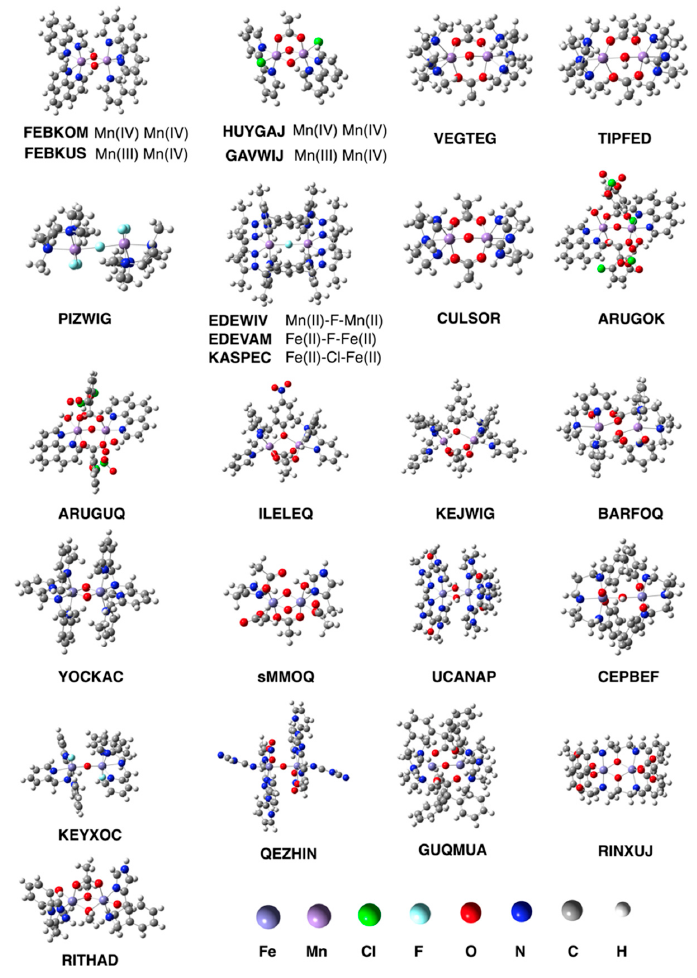
Figure 1. Twenty-five dinuclear manganese and iron complexes (for details, see also Table S1 and Table